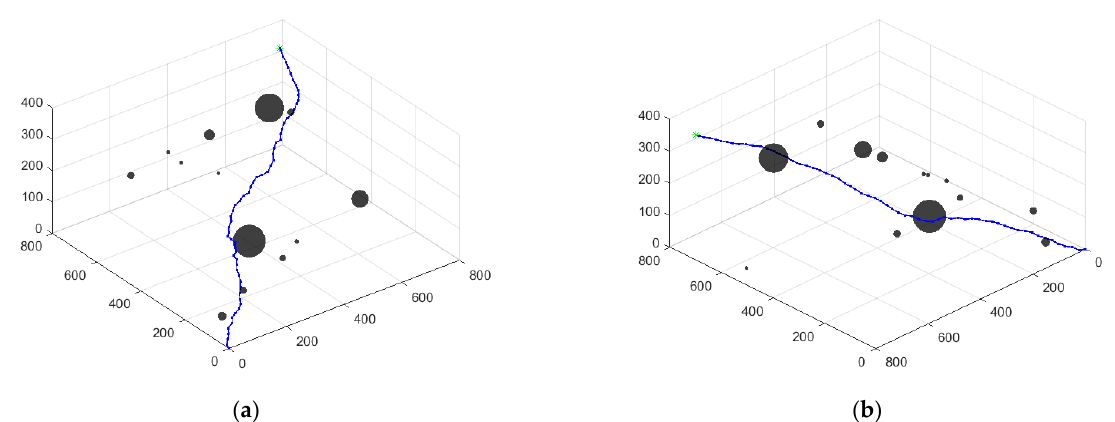
Figure 11. Different view of the path planning of the improved RRT algorithm: ( a ) view 1; ( b ) view 2.